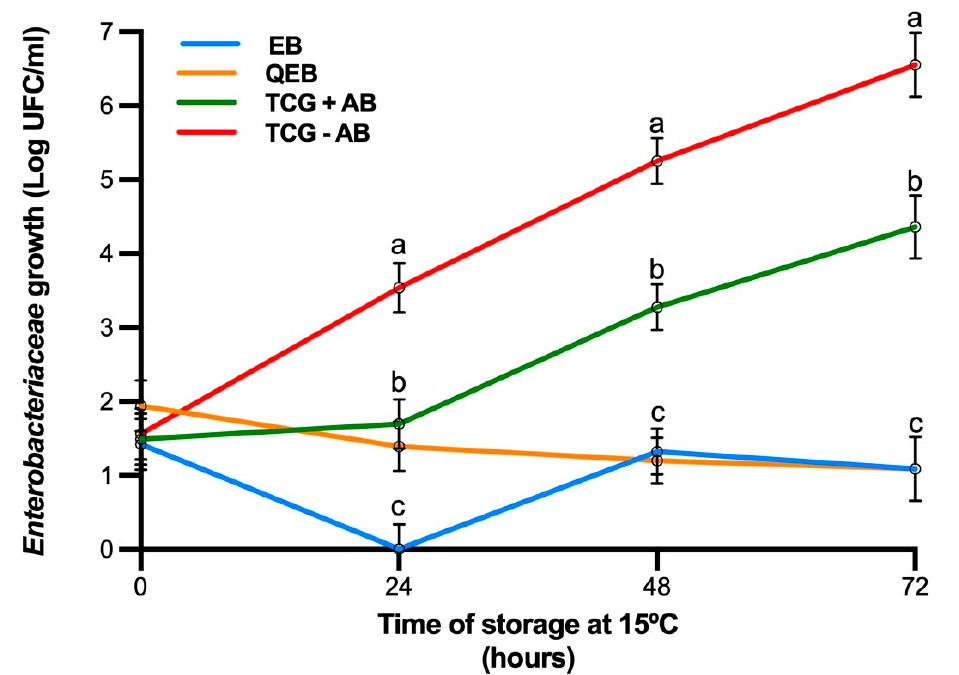
Figure 1. Bacterial growth (Log CFU/mL; mean ± SEM) in sperm samples from the rabbit where there was storage at 15 °C for 72 h in four extenders: EB: TCG supplemented with EDTA (20 mM) and bestatin (10 mM). QEB: TCG supplemented with EDTA (20 mM), bestatin (10 mM) and nanoparticles of chitosan-alginate (0.05%). TCG+AB: TCG extender supplemented with 100 IU/mL penicillin + 100 µg/mL streptomycin. TCG-AB: TCG extender without antibiotics. Different superscripts (a, b and c) indicate differences in values at the same time point ( p < 0.05).